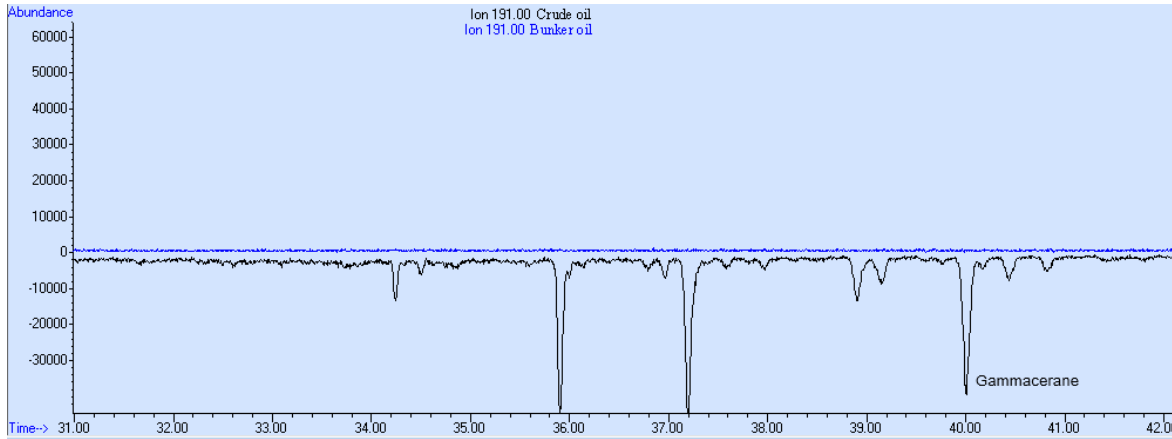
Figure 4. Comparison of Pr/Ph ratio between crude oil and petroleum products.